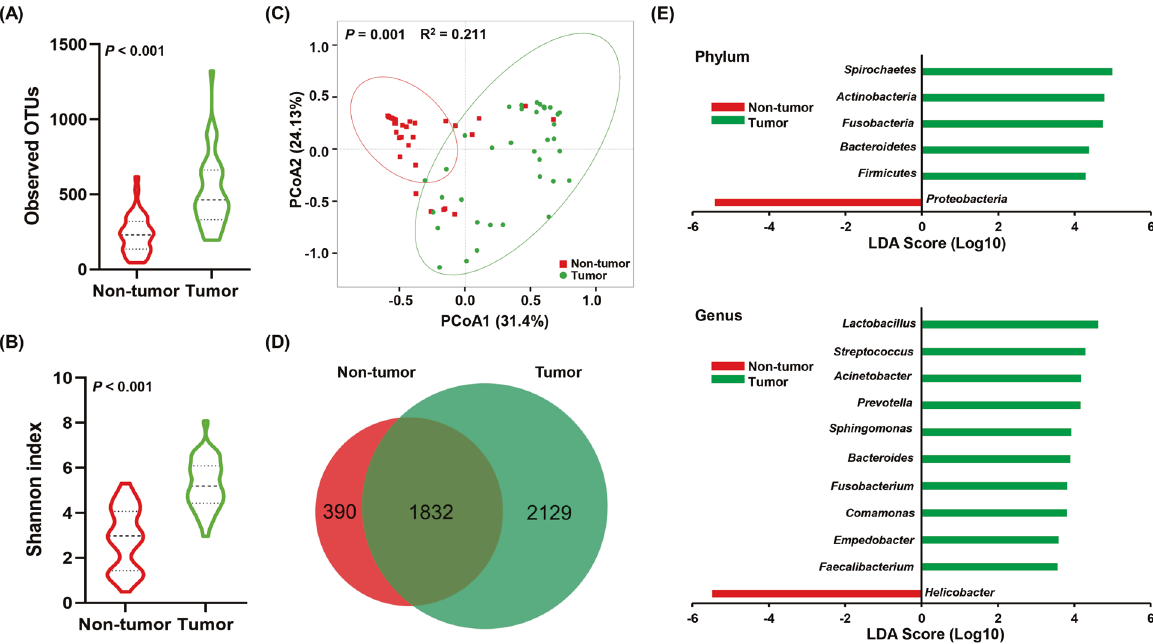
Fig. 1 Altered gastric microbiota in 37 gastric cancer (GC) tissues compared with matched non-tumor tissues. A, B The observed OTUs and Shannon indices were used to evaluate the microbial diversity of the paired tumor and non-tumor tissues. The Wilcoxon matched-pairs signed rank test was performed. C Principal coordinate analysis (PCoA) of the weighted UniFrac distance demonstrated that the non-tumor and tumor tissues showed two distinct clusters. D The Venn diagram illustrates the overlapped OTUs between the paired GC tumor tissues and